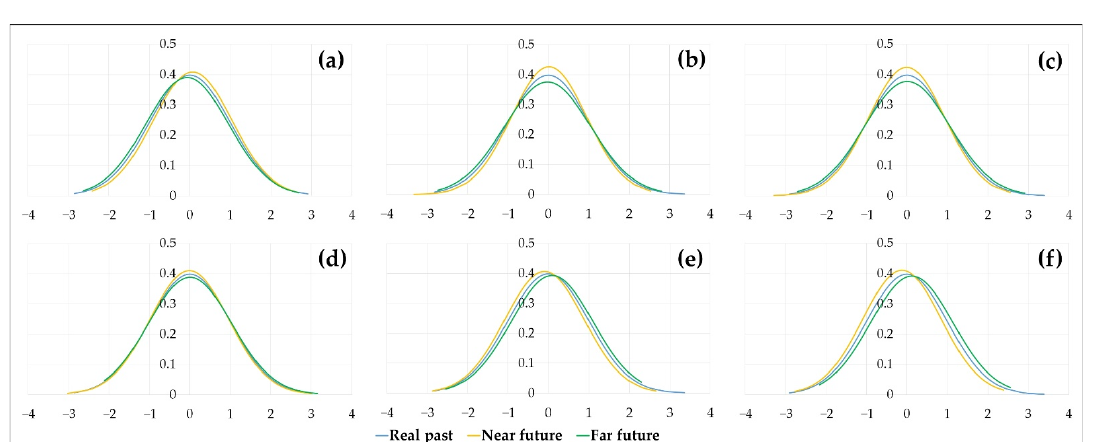
Figure 11. Deviation of RDI index with 12-month accumulation period: ( a ) Šventoji—Ukmerg˙e under RCP 4.5; ( b ) Venta—Leckava under RCP 4.5; ( c ) Minija—Kartena RCP under 4.5; ( d ) Šventoji— Ukmerg˙e RCP under 8.5; ( e ) Venta—Leckava under RCP 8.5; ( f ) Minija—Kartena under RCP 8.5.